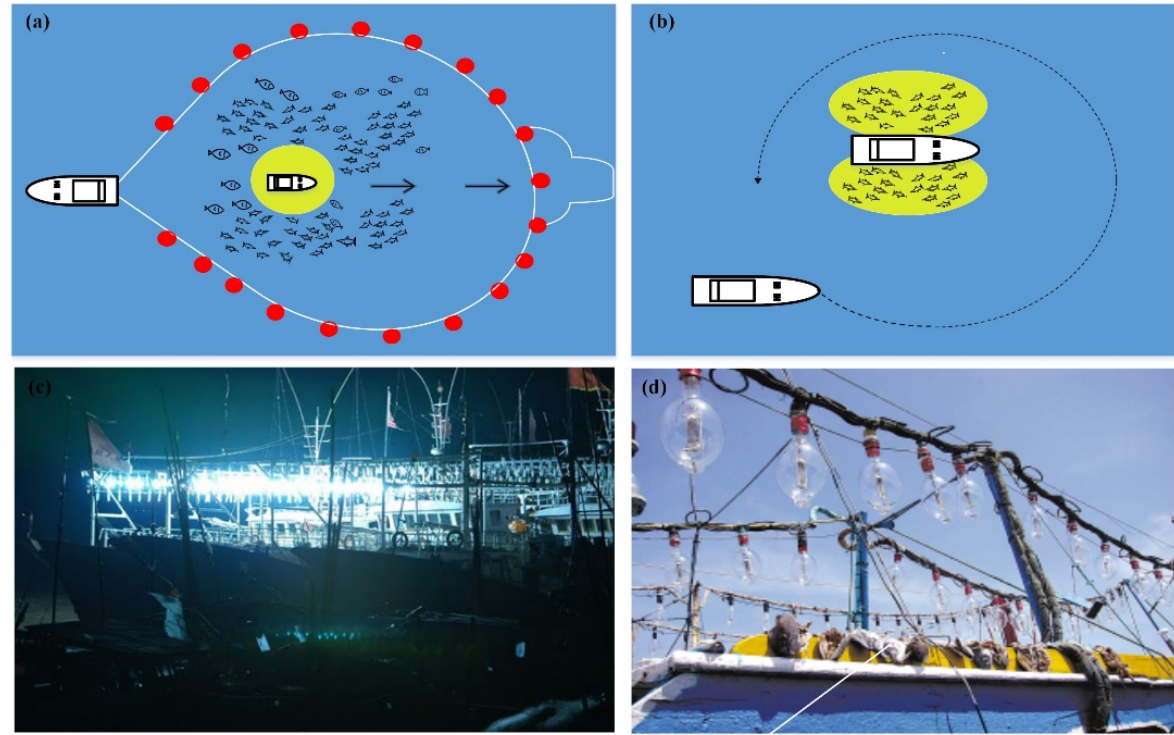
Figure 1. Illustration of light fishing ( a , b ) Light fishing method (light purse seine fishing) ( c , d ) different light types ( c ) Light Emitting Diode (LED)( d ) incandescent.